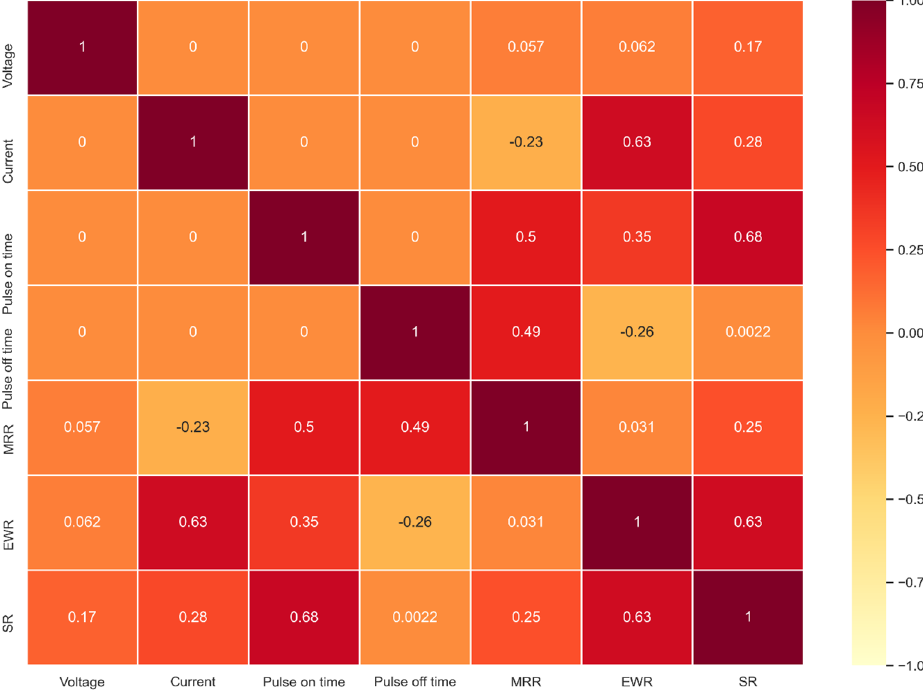
Figure 3. Residuals versus linear regression predicted ( a ) MRR ( b ) EWR ( c ) SR. 3.1.4. Random Forest Regression Models In this section, random forest regression models are developed for MRR, EWR and SR. However, since random forest regression models are known to be sensitive to the number of regressors, a sensitivity study is undertaken and reported in Table 3. It is ob- served that the highest 𝑅 (cid:2870) and the lowest MSE is recorded for 200 regressors. Thus, 200 regressors are chosen as the optimal for carrying out the rest of the study.